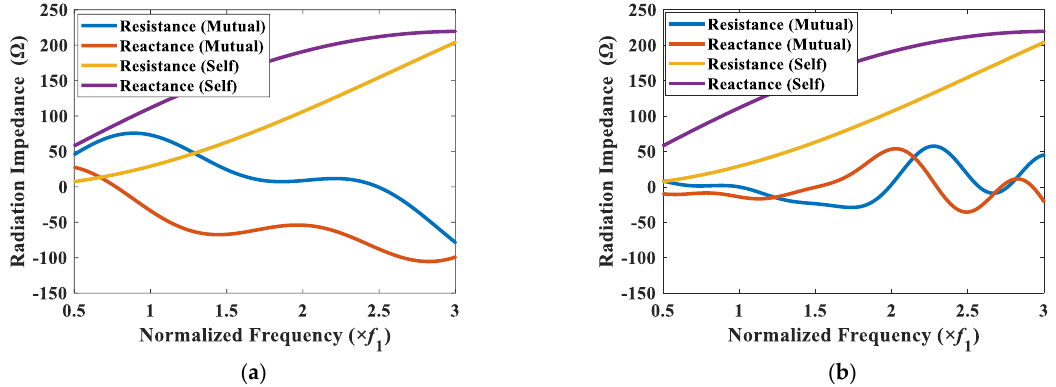
Figure 11. Self − radiation impedance 𝑍 1𝑠 and total mutual radiation impedance 𝑍 1𝑡 of the cymbal 1 transducer for CTC spacings of ( a ) 0.2 𝜆 ; ( b ) 0.5 𝜆 .